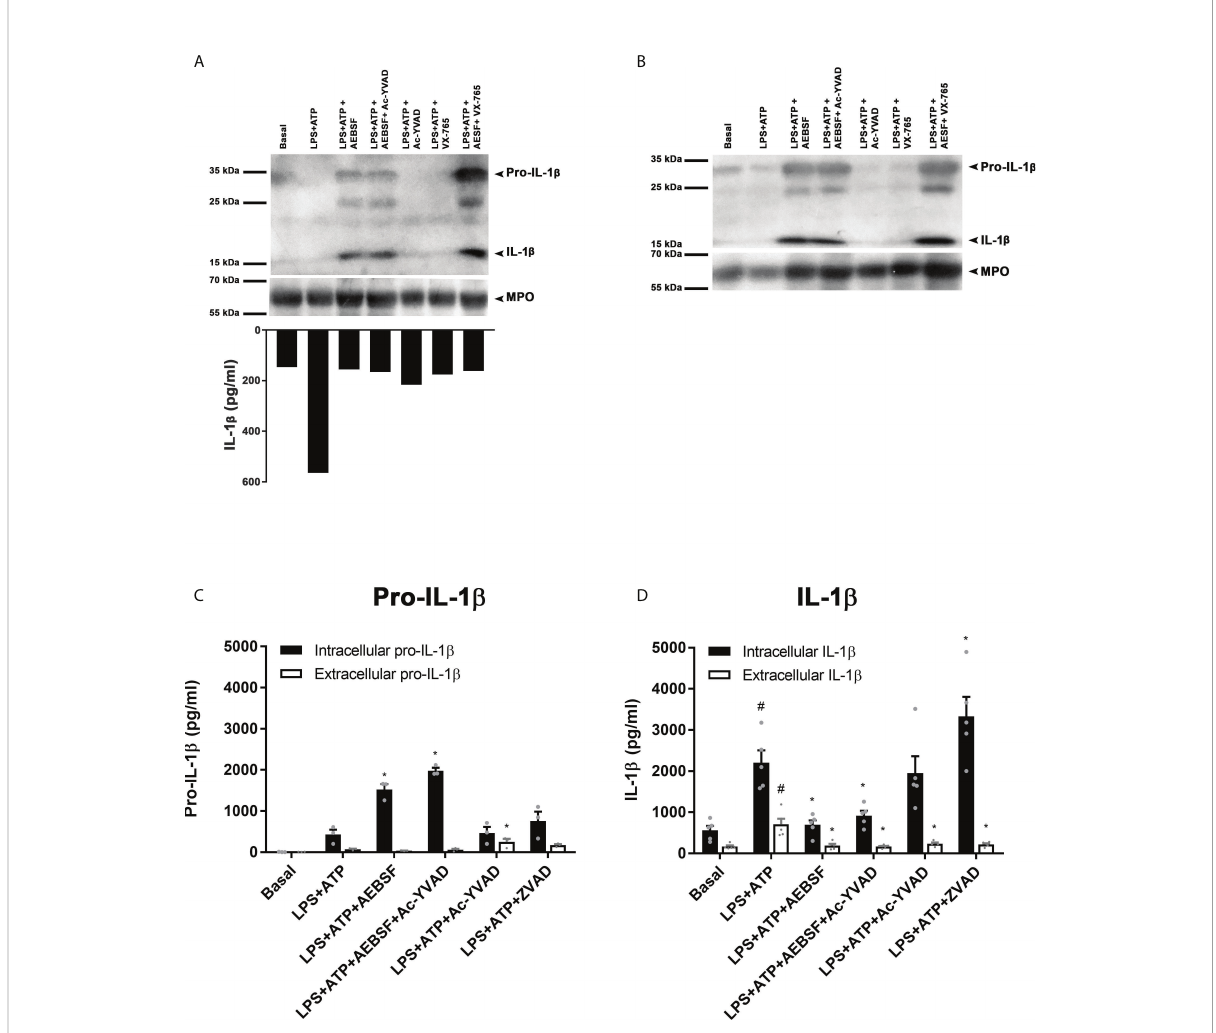
FIGURE 8 NSPs but not caspase-1 play a major role in pro-IL-1 b processing. ( A upper part and B ) Neutrophils were pre-treated for 30 min in the presence or absence of AEBSF (1 mM), Ac-YVAD-CMK (50 µM), VX-765 (50 µM) or their combination of AEBSF and one of the caspase-1 inhibitors, then cultured with or without LPS for 2 h and after were stimulated or not with ATP (2.5 mM) for another 1.5 h. Then, whole cell extracts were subjected to Western blot (A, B) and supernatants collected for ELISA quanti fi cation (A; bottom part). Western blots in A and B belong to the same cells extracts that were electrophoresed and electro-transferred twice, one probed with an anti-human IL-1 b antibody from Santa Cruz (antibody H-153; A) and the other one with a Novus Biological antibody (NB600-633; B). ( A , upper part and B ) Representative Western blot assay (n=6; A and n=2; B ) of pro-IL-1 b and mature IL-1 b expression; and (A, bottom part) IL-1 b concentration in culture supernatants of the same cells from which lysates were immunoblotted in (A) and (B) . (C, D) Concentrations determined by speci fi c ELISAs of pro-IL-1 b (C) and IL- 1 b (D) in culture supernatants and cell pellets of neutrophils stimulated in the absence or presence of AEBSF (0.35 mM), Ac-YVAD-CMK (50 µM), the combination of AEBSF and Ac-YVAD-CMK, or Z-VAD-FMK (50 µM) added 30 min before LPS stimulation, then stimulated or not for 2 h with LPS and then treated or not with ATP for another 1.5 h. Data represent the mean ± SEM of experiments with 3 (C) or 5 (D) donors performed in duplicate. *p<0.05 vs LPS+ATP; #p<0.05 vs Basal. One-way ANOVA with Sidak´s multiple comparisons